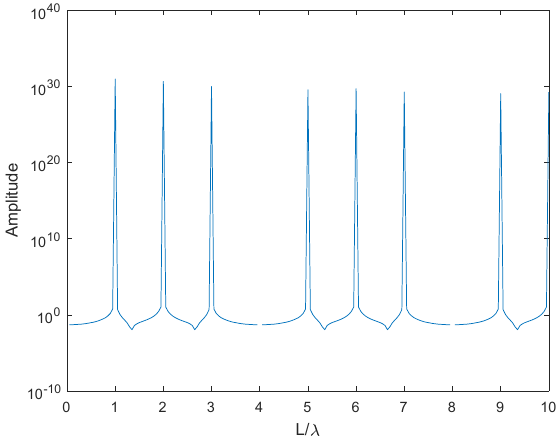
Figure 4. Radiation capability (z − mode dipole).